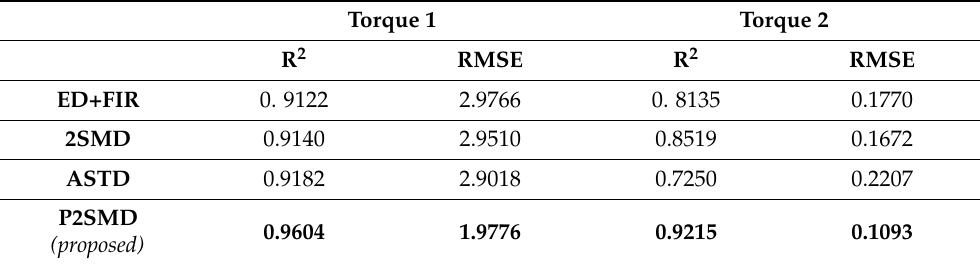
Table 4. Results obtained for the direct validation in terms of R 2 and RMSE. The best results are shown in bold.